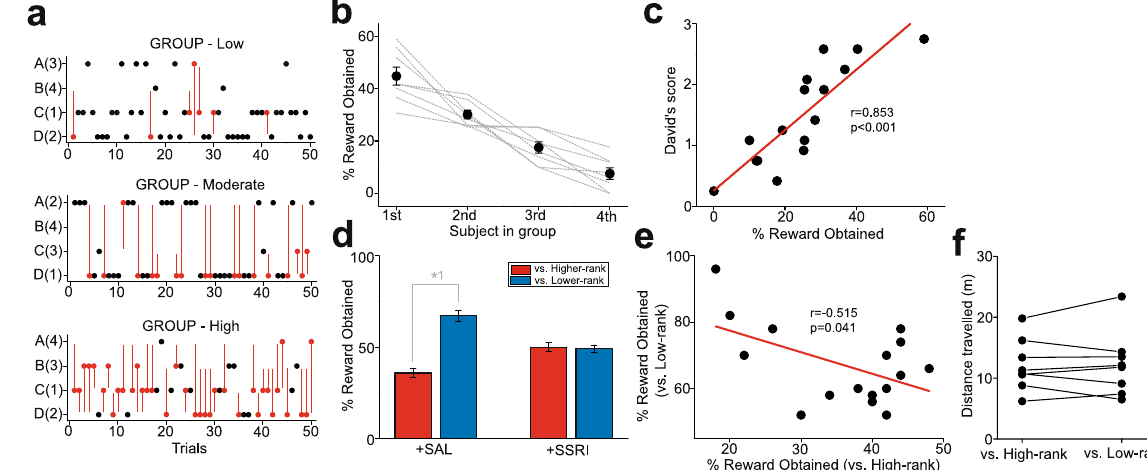
Figure 2. Decision-making under conflict in social obedience-like behavior and the effects of SSRI. ( a ) A graph showing 3 representative groups of trial-by-trial competition for the first 50 trials with low (top), moderate (middle), and high (bottom) frequencies of agonistic interactions between subjects during the competition. Subjects in each group are denoted as A-D, and parentheses indicate the ranks of the subjects based on the number of obtaining the rewards. Red and black circles indicate the trials with and without agonist interactions. The animals that exhibited agonist interactions were connected with red lines, and the ones that obtained the rewards were indicated with red circles. ( b ) A graph showing FAP of mice in each group (dashed lines), and the averages of all groups (circles), ranked from 1st to 4th, based on the number of first food reward access over other mice. Error bars indicate s.e.m. ( c ) A graph showing a correlation between DS and FAP. ( d ) A graph, along with illustration of individual cases, showing the number of food accesses (expressed as percentage of trials) of test subjects with SAL and SSRI administration over higher- and lower-FAP opponents. * 1 p < 0.001. ( e ) A graph showing a correlation between the number of food accesses against lower- vs. higher-FAP opponents. ( f ) A graph showing spontaneous locomotion of test subjects when they were placed with higher- or lower- FAPopponents, but without food reward presentation, in the open field